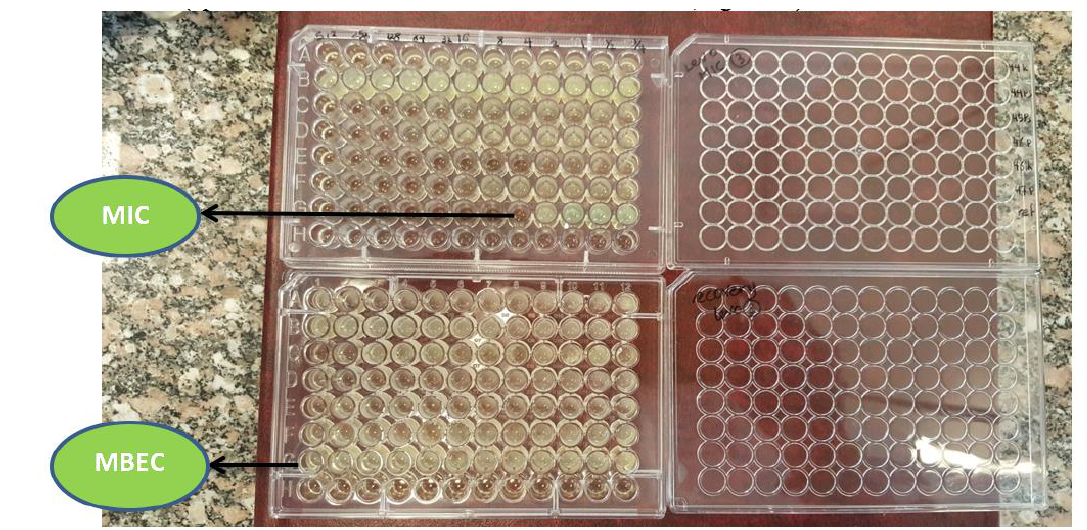
Figure 2. MIC versus MBEC results of